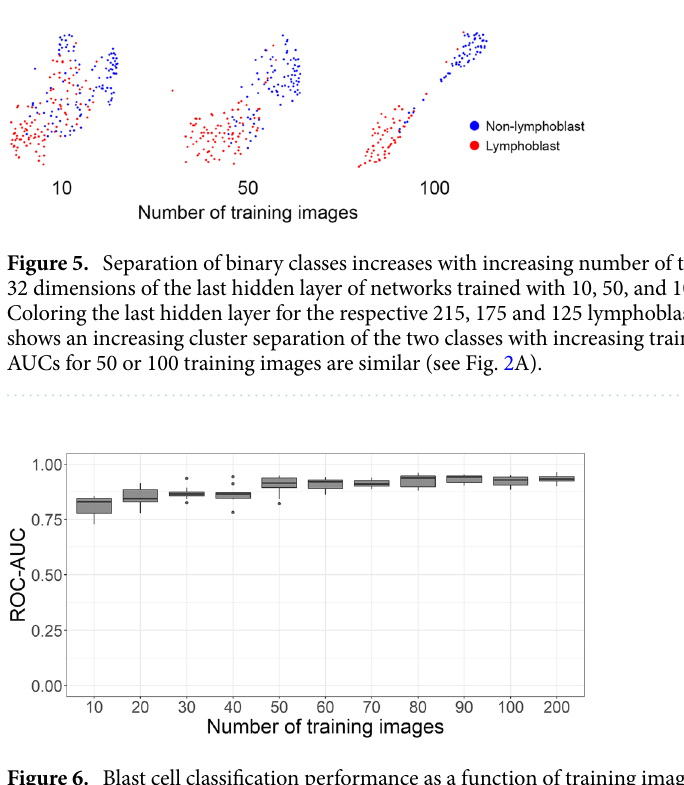
Figure 6. Blast cell classification performance as a function of training images for the AML dataset. We observe a saturation at around 50 training images. Boxes show median and 2nd and 3rd quartile, with whiskers indicating the highest and lowest point within 1.5 times the interquartile range.